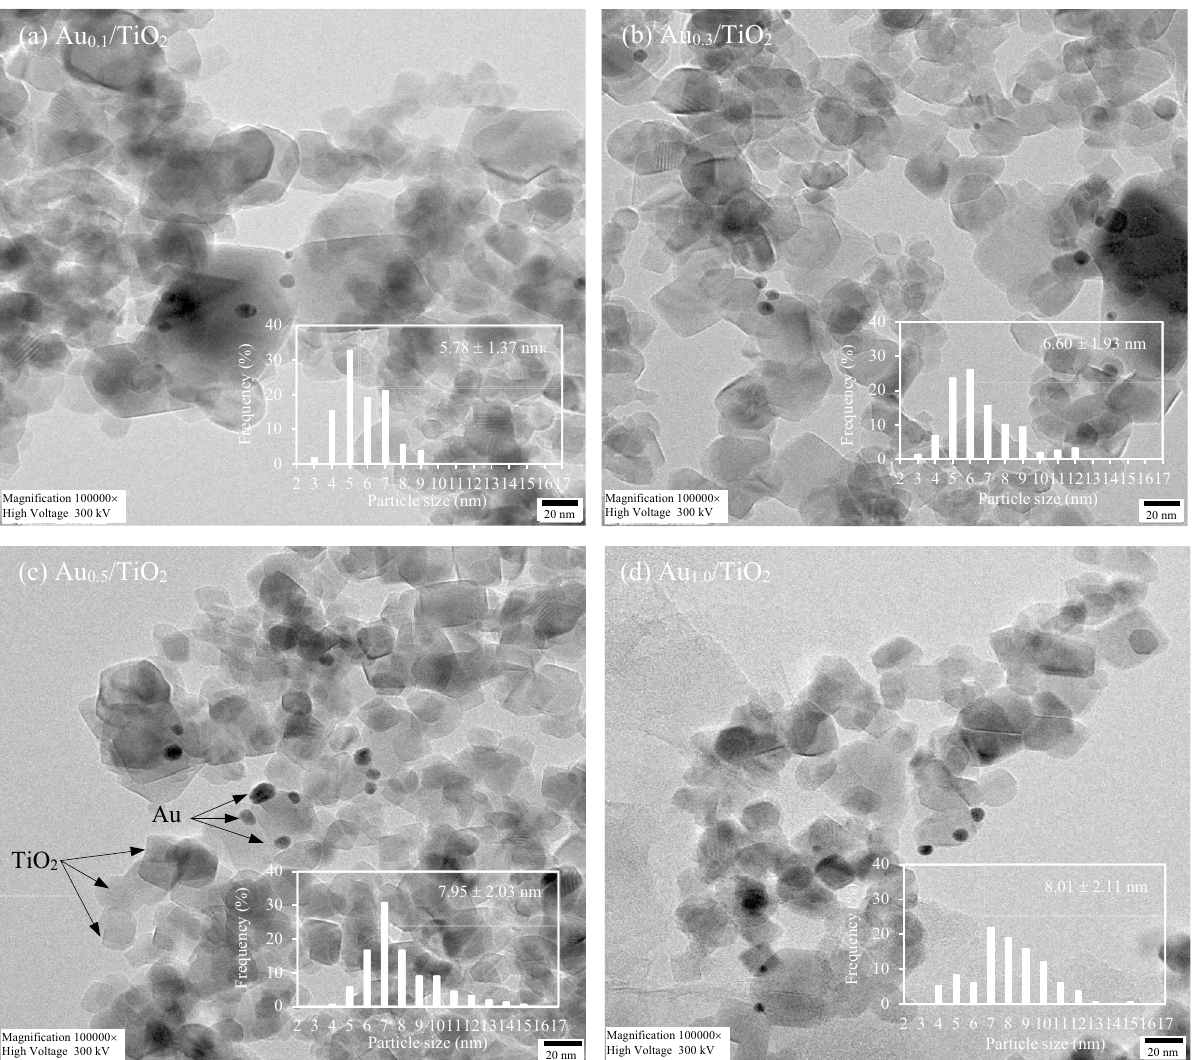
Figure 3. Representative HRTEM of Au x /TiO 2 NPs synthesized by photodeposition and their particle size distributions at different gold loadings in the range of 0.1–1.0